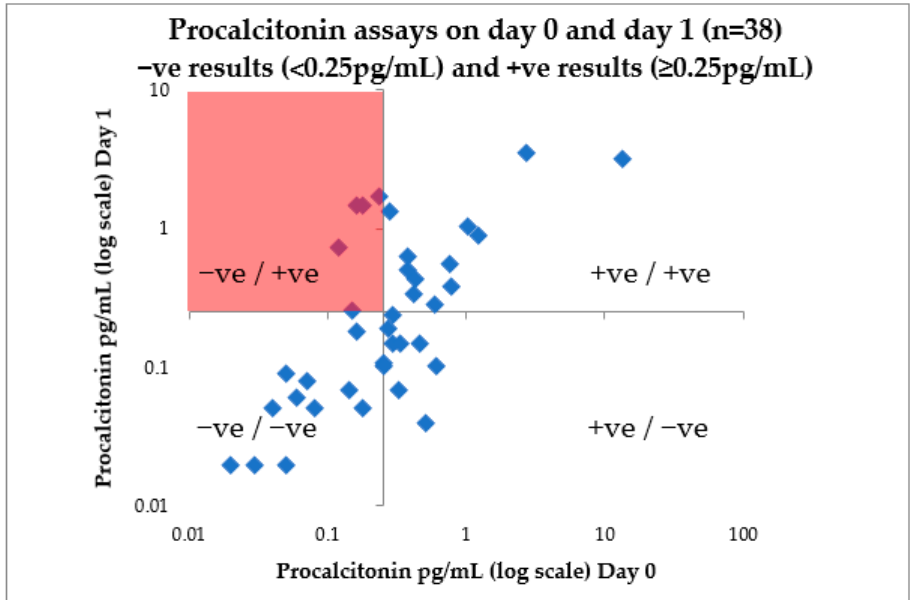
Figure 2. Reproducibility of procalcitonin taken on days 0 and day 1 of patient admission with COVID-19, London, December 2020–February 2021 (UK wave 2). Procalcitonin +ve results (defined locally as ≥ 0.25 pg/mL) and − ve results (defined locally as <0.25 pg/mL) are presented at day 0 (on admission) and day 1 (post-admission) to test reproducibility of this clinical